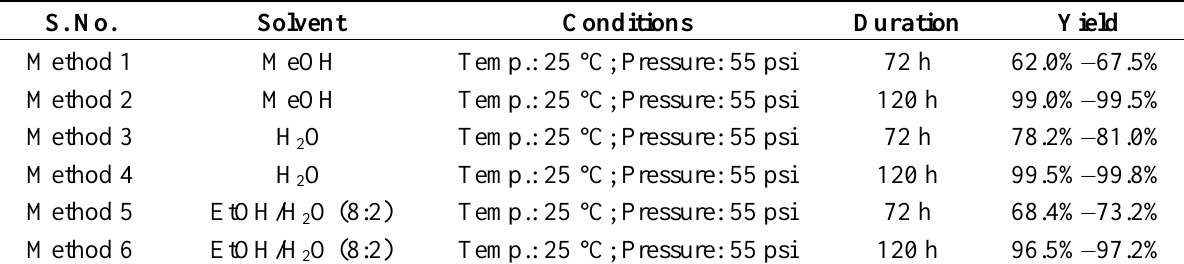
Table 3. Catalytic hydrogenation of Rebaudioside A ( 1 ); Rebaudioside B ( 2 ); Rebaudioside C ( 3 ); and Rebaudioside D ( 4 ) using Rh/C and yields of various methods. S. No.